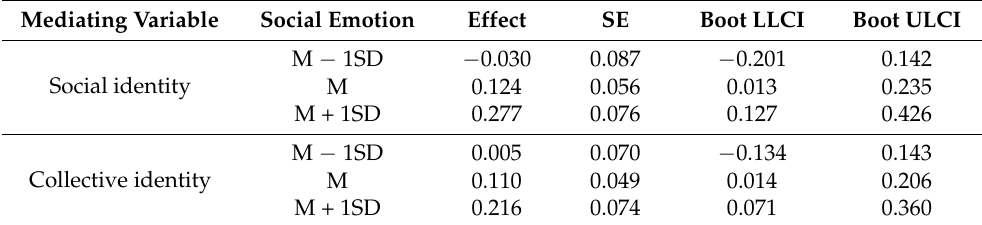
Table 6. Analysis of the mediating effect of identity at different levels of social